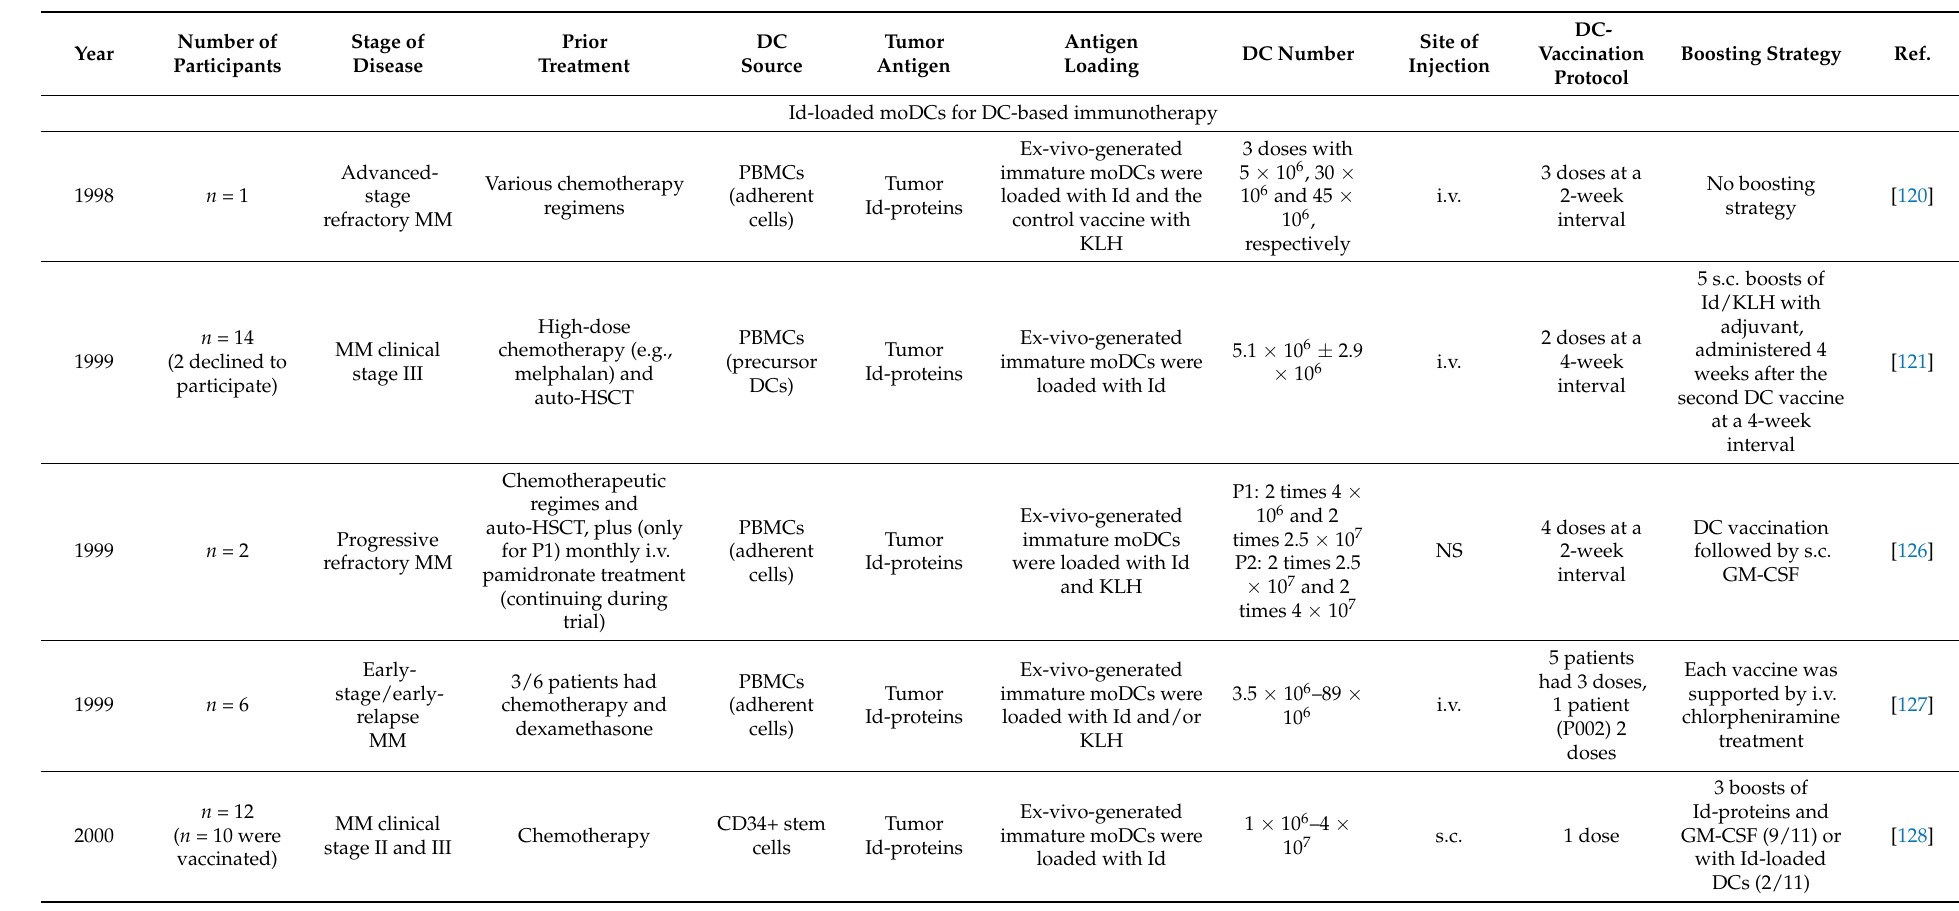
Table 1. Overview of clinical trials using DC-based vaccination strategies in MM